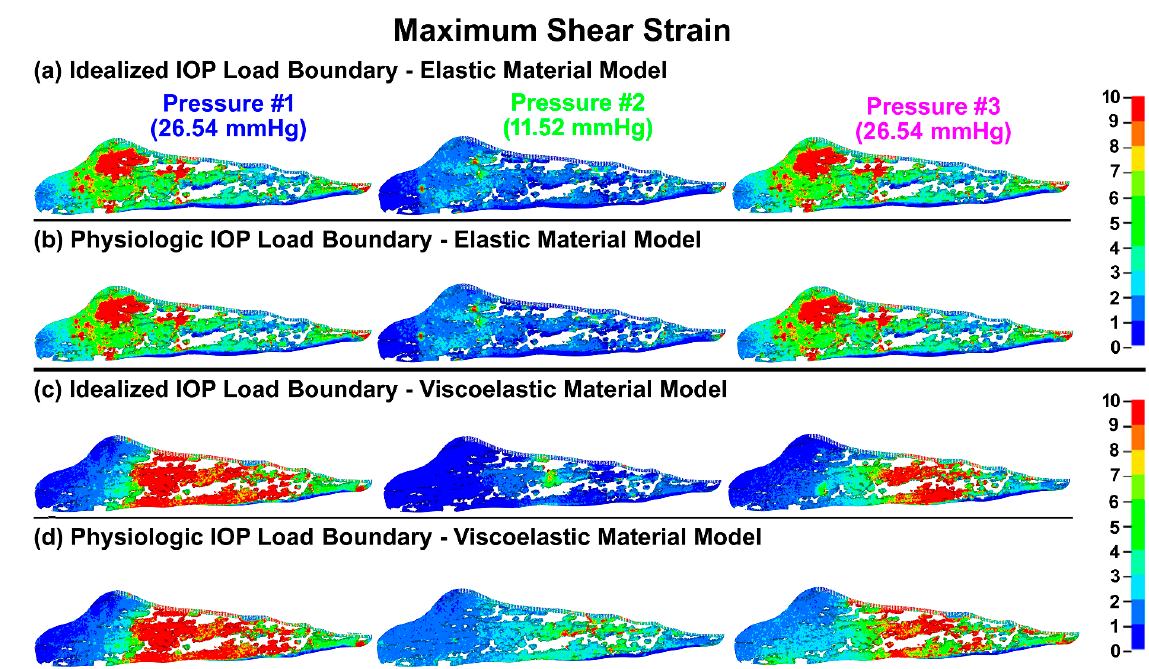
Figure 5. The maximum shear stress in the TM/JCT/SC complex with ( a ) idealized IOP load bound- ary (elastic material), ( b ) physiologic IOP load boundary (elastic material), ( c ) idealized IOP load boundary (viscoelastic material), and ( d ) physiologic IOP load boundary (viscoelastic material) at three different IOPs.